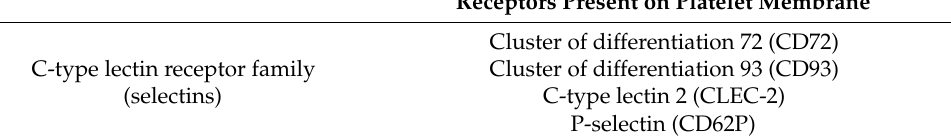
Table 4. Overview of platelet granule components (receptors and/or ligands) [14,22–38]. The receptors found on platelet membranes are of significance in the platelets’ primary function, which is to hinder haemorrhage after vascular injury. These receptors aid in the platelets’ adhesion, activation, and, finally,